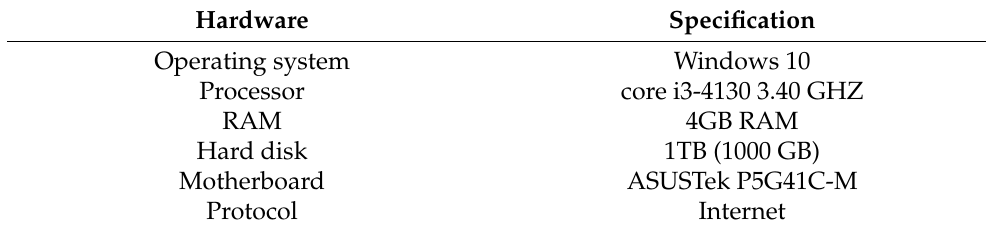
Table 1. Hardware